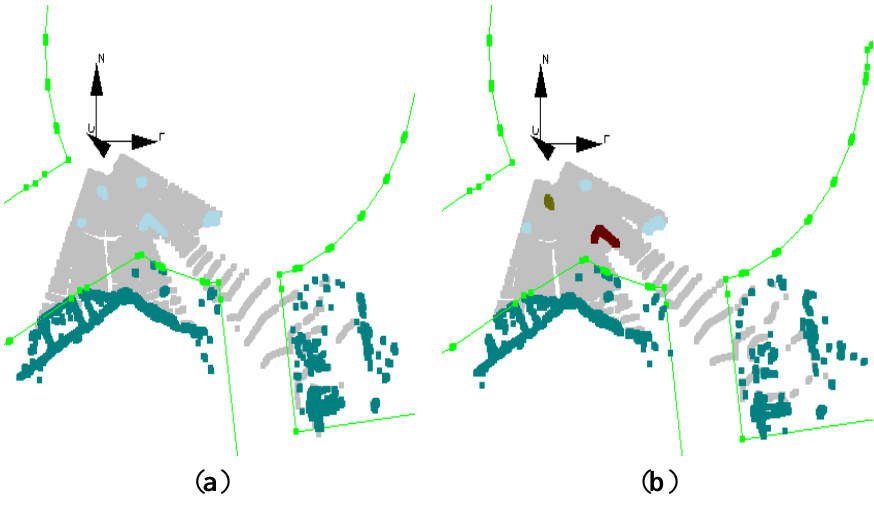
Figure 8. ( a ) Tracking results at first epoch (dataset #5); all objects labeled as static; ( b ) the car (brown L shape) and cyclist (green dot) are labeled as moving objects after 0.4 s.